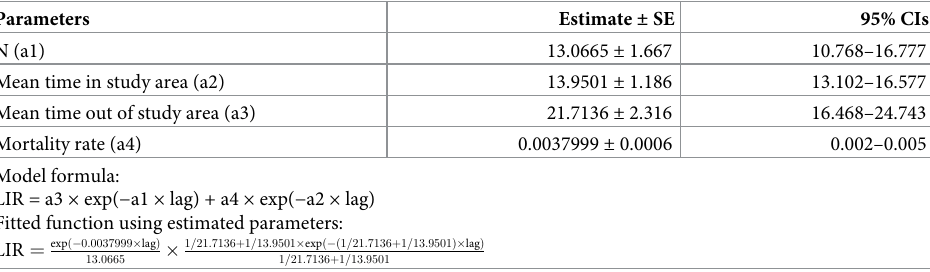
Table 4. Best-fitting model parameter estimates and fitted model formula for the lagged identification rate, which included emigration, reimmigration and